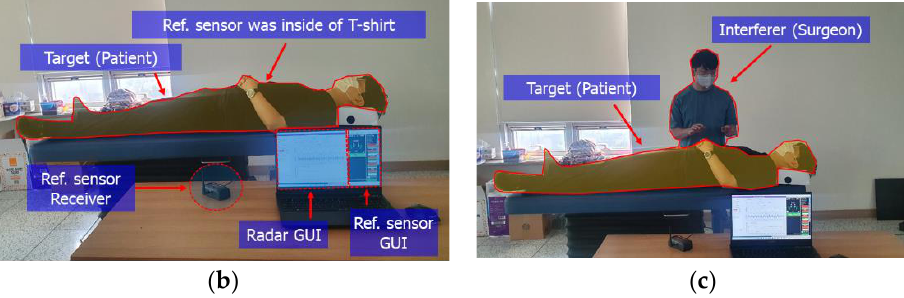
Figure 9. The photographs of experiment setup in laboratory. ( a ) is the photo of radar module installed on back of surgical bed, ( b ) is the photo of monitoring patient’s vital signs, and ( c ) is the photo of monitoring patient’s vital signs with surgeon as interferer.